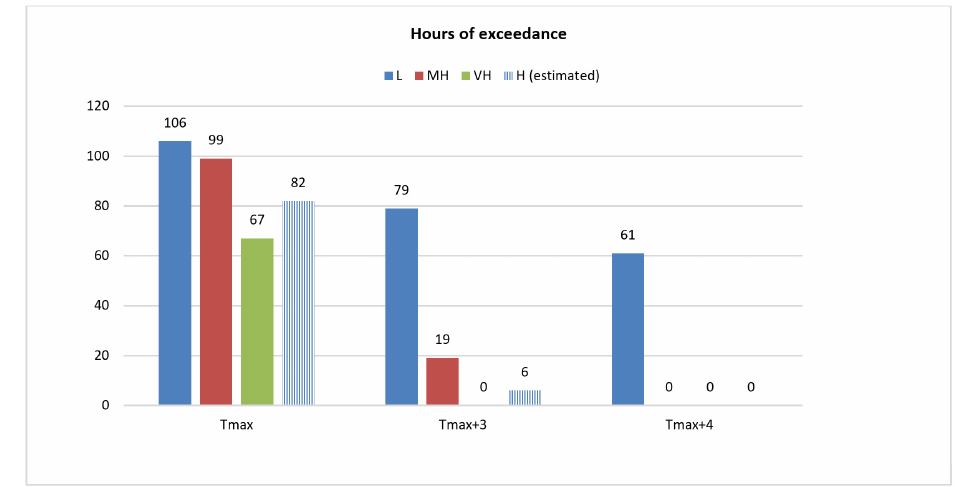
Figure 8. Hours of exceednce in all tested rooms during 23–30 July 2019, Hours